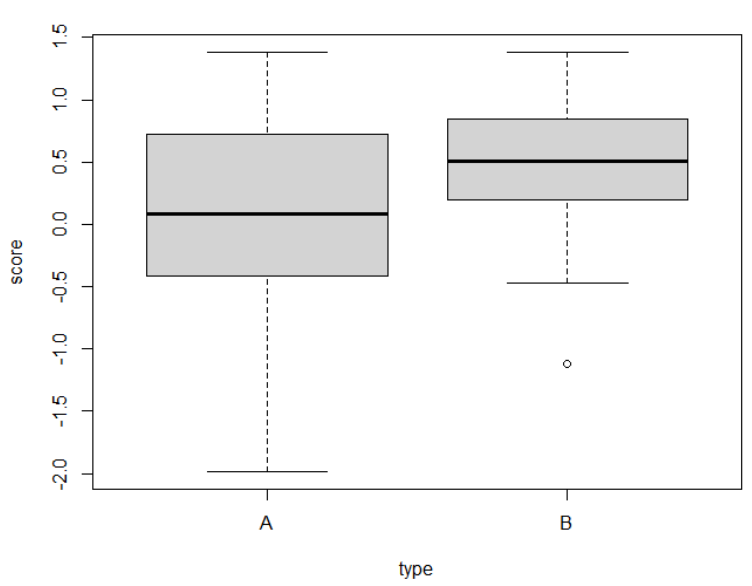
Figure 8. Boxplot about the log-scores for the two types of